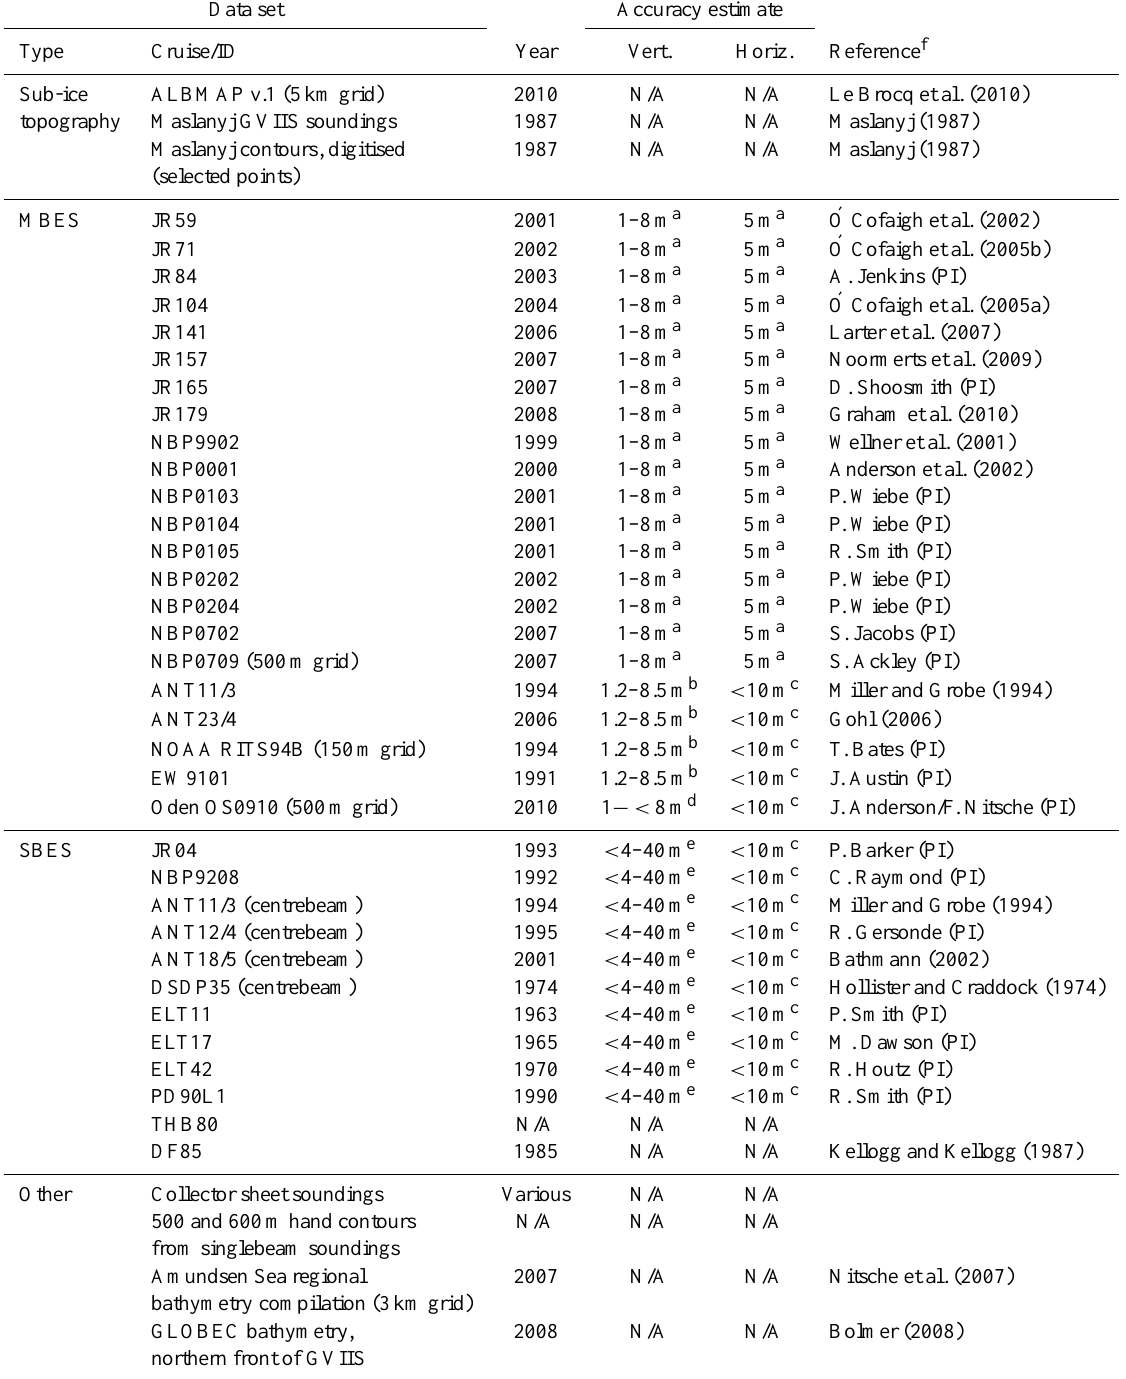
Table 1. Data sets used in the new bathymetry compilation. SBES: single-beam echo sounder data; MBES: multibeam echo-sounder data; PI (Principal